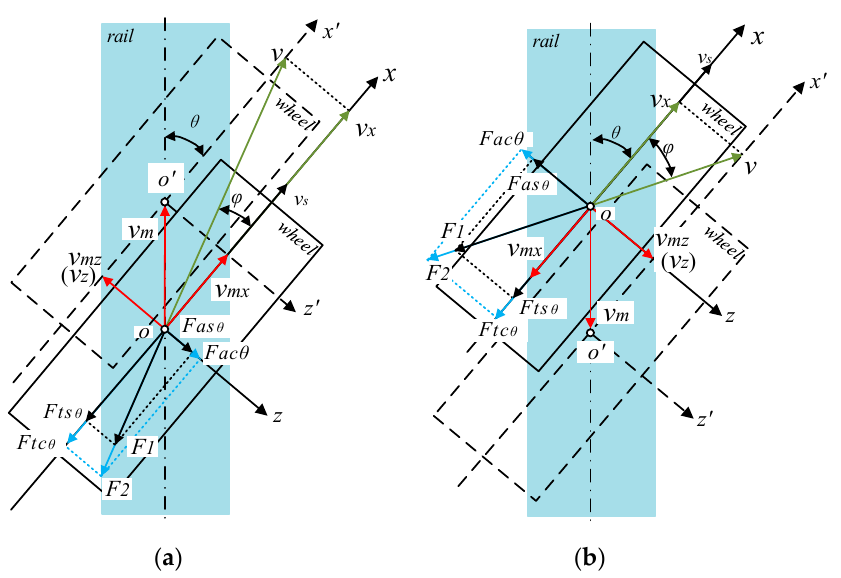
Figure 12. Schematic diagram of the grinding force of the grinding wheel in a horizontal plane when the end face of the grinding wheel has an included angle: ( a ) up-grinding; ( b ) down-grinding.